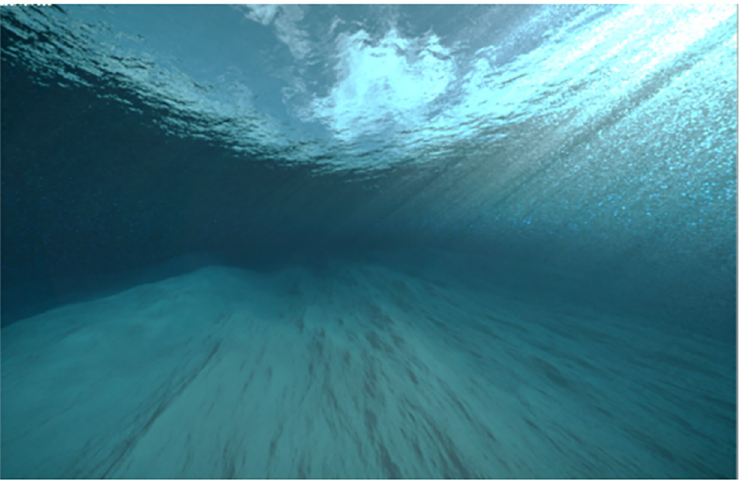
Fig 2. Screenshot of the baseline VE condition as used in the online